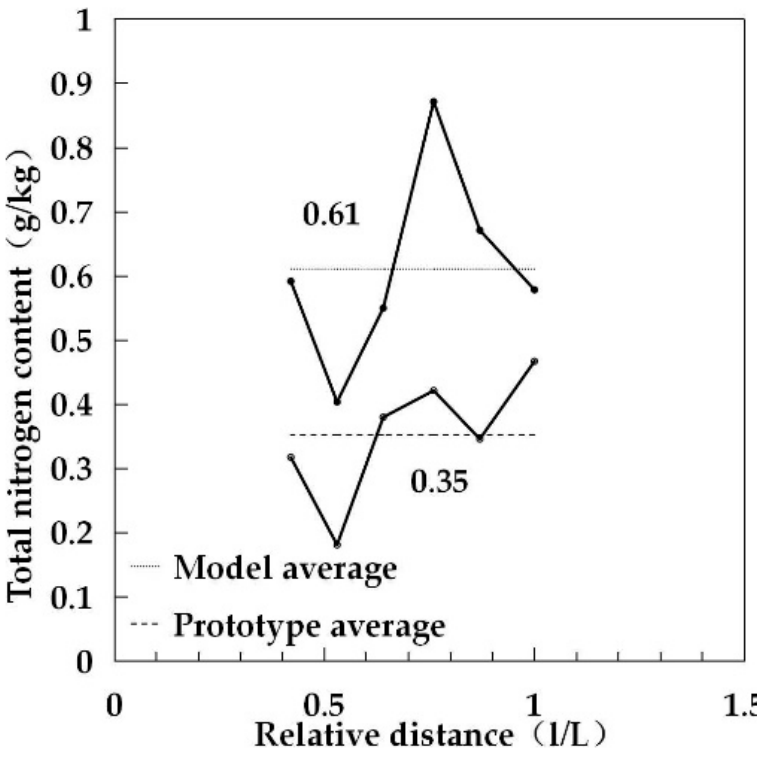
Figure 12. Changes in soil nitrogen content with distance in trenches of the prototype and model.